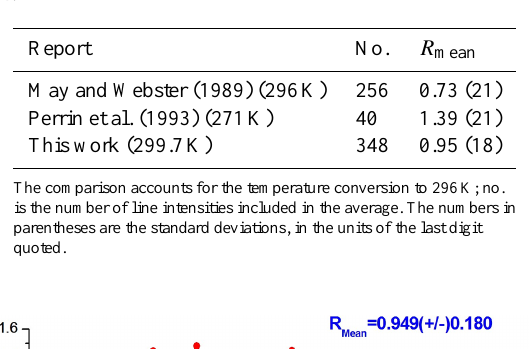
Table 4. Average ratios R mean of line intensities included in MIPAS-2015 (at 296K) and measured in the literature and in this work.